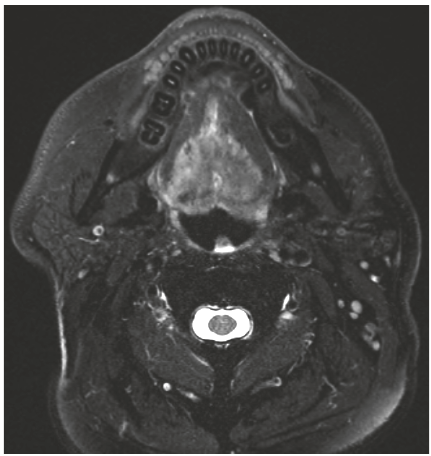
Figure 1: MRI of lesion in base of tongue.